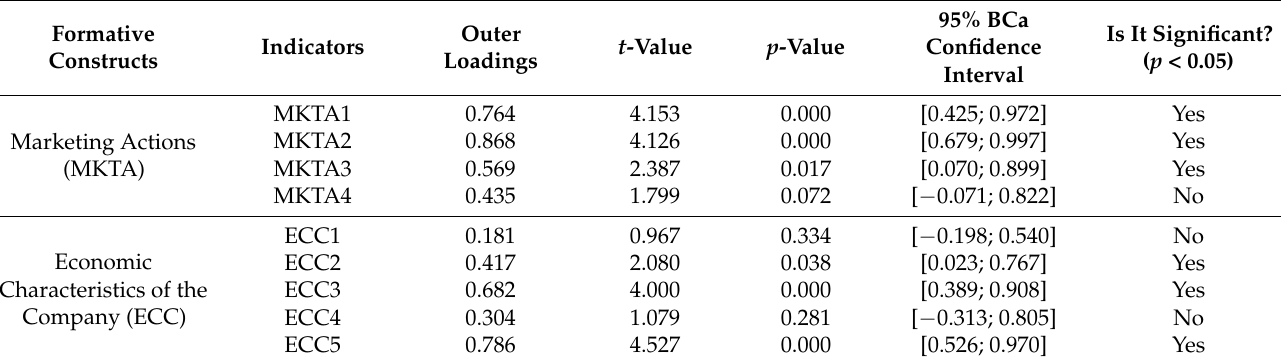
Table 7. Significance and relevance of outer